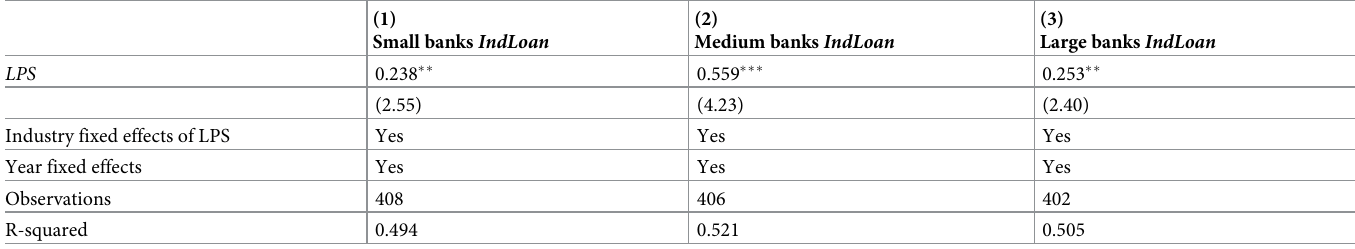
Table 8. The largest private shareholder and bank loans: Group test. This table reports the estimation results from OLS regressions analyzing the impact of the largest private shareholder on bank lending to their industry, with a different sample in each column. Columns 1–3 uses IndLoan as the dependent variable. Variables are defined in S1 Appendix. The top three industry in each region with a share of the overall economy has been removed. The sample period is from 2007 to 2020. In parentheses are t- statistics. ��� , �� , � indicate statistical significance at the 1%, 5%, and 10% level,